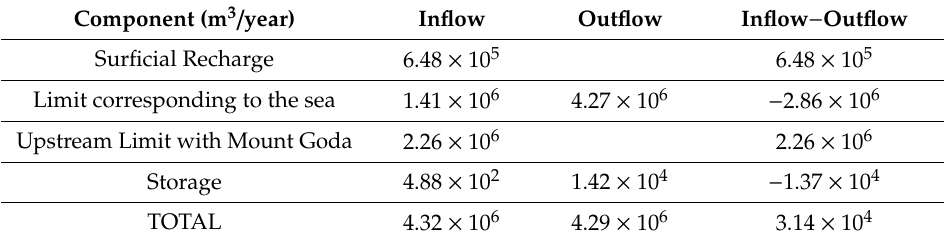
Table 5. Annual water balance of the aquifer, simulated by the model and corresponding to the equilibrium state of the seawater intrusion.